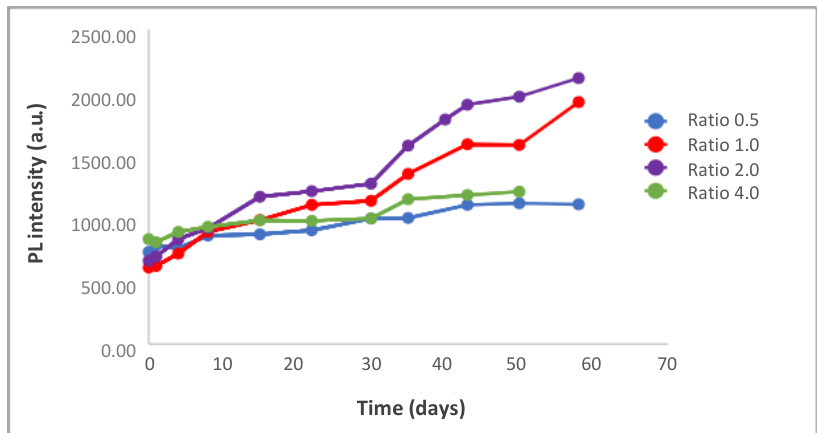
Figure 6. Influence of [Cd2+] F /[BSA] F at 4 °C. Temporal evolution of Photoluminescence intensity of CdS QDs solutions with different [Cd 2+ ] F /[BSA] F ratios.